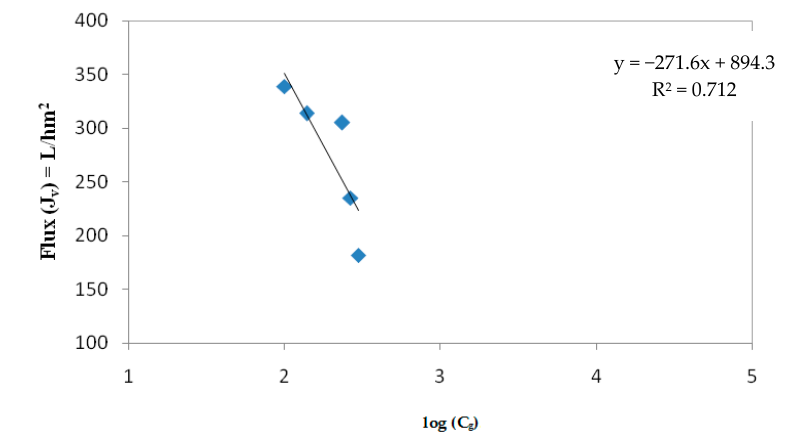
Figure 9. Variation of the permeate flux with log ( C g ).